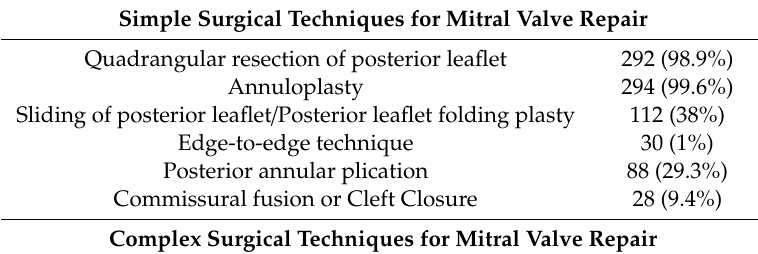
Table 2. Surgical techniques used in the study population.